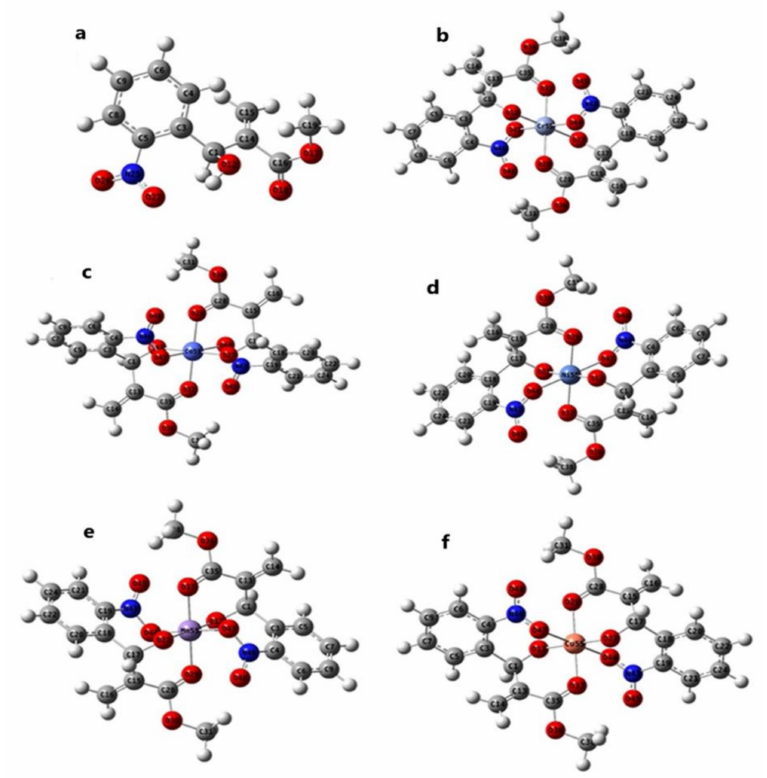
Figure 4. Theoretically optimized geometries of compounds 3 – 8 . ( a ) [(MNHA)], ( b ) [Cr(MNHA) 2 ] + , ( c ) [Co(MNHA) 2 ] + , ( d ) [Ni(MNHA) 2 ], ( e ) [Mn(MNHA) 2 ], and ( f ) [Cu(MNHA) 2 ]. The stable geome- tries confirmed each metal coordinated octahedrally with two tridentate ligand